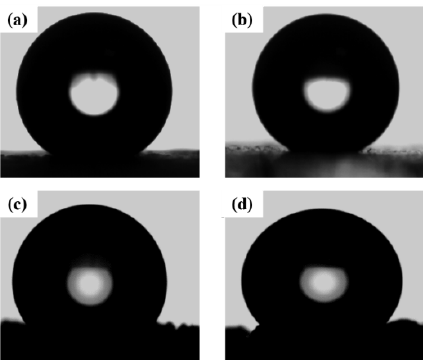
Figure 5. Water contact angle measurement of glass (( a ) 159, ( b ) 165) and sand (( c ) 150, ( d ) 148) coating with SiO 2 /TMCS, respectively.